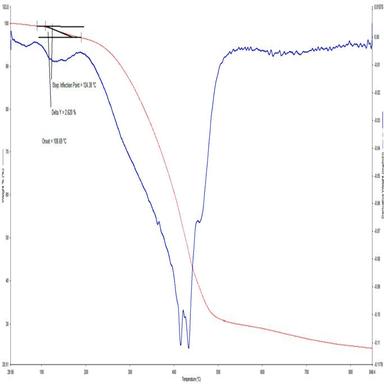
Result of thermogravimetric analysis on OGH specimen.